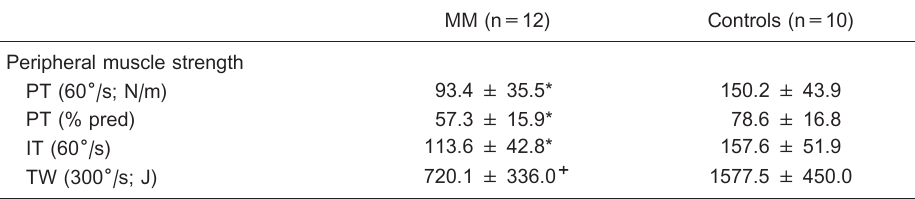
Table 2. Peripheral muscle evaluation of patients with mitochondrial myopathy (MM) and healthy controls.